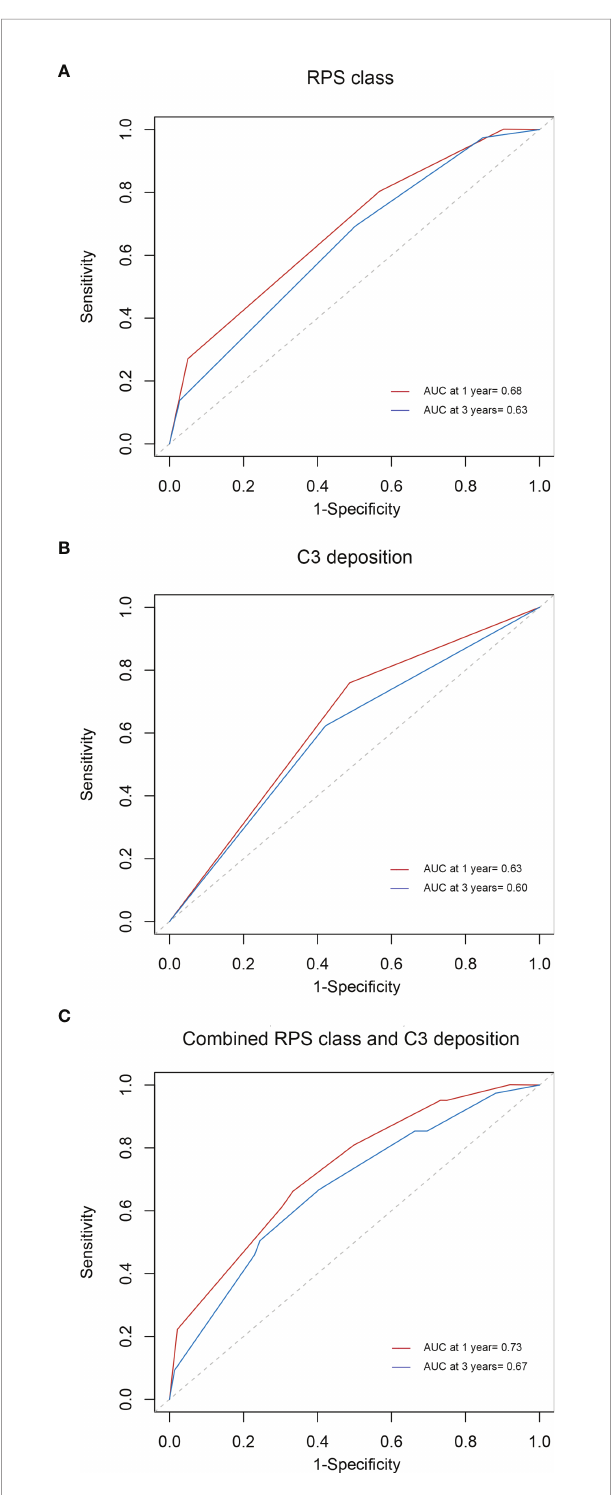
FIGURE 5 | Time-dependent ROC curves for the estimation of prognostic accuracy with RPS class (A) , C3 deposition (B) , or the combination of C3 deposition and RPS class (C) in diabetic nephropathy. ROC, receiver operating characteristic; RPS, Renal Pathology